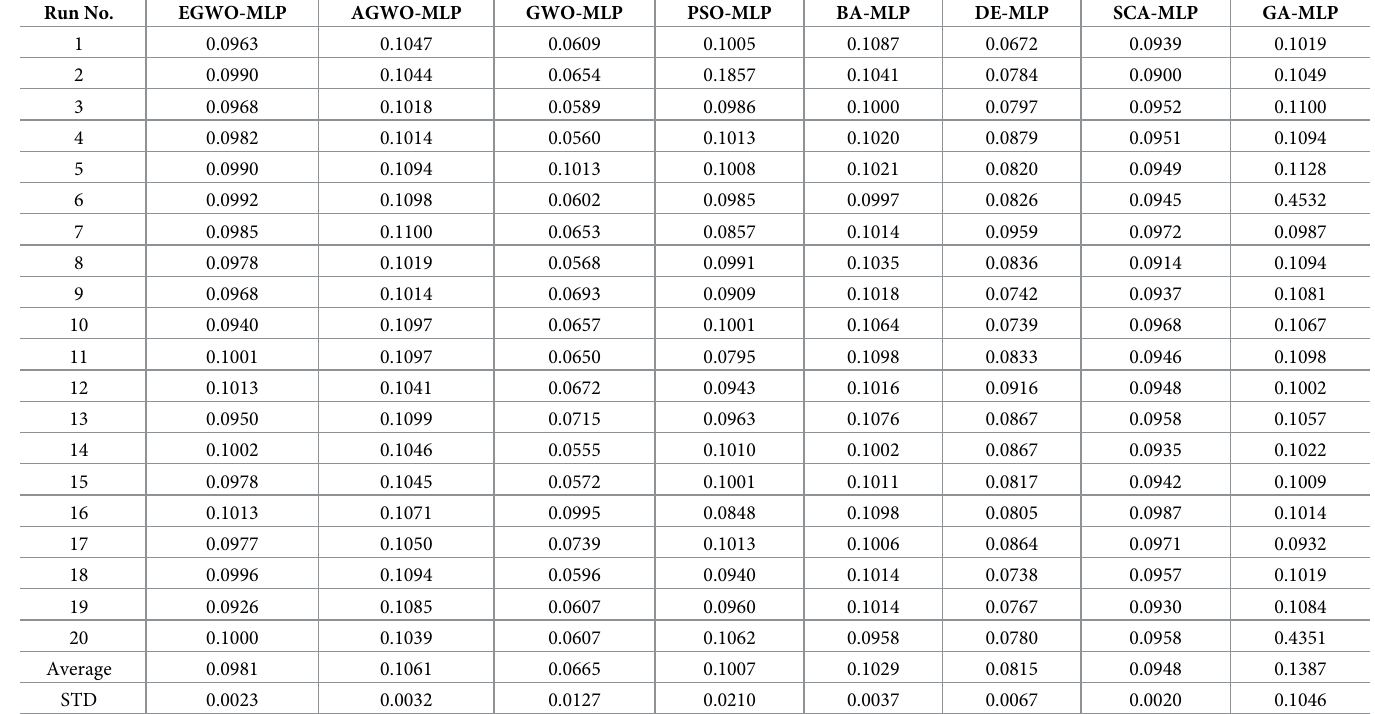
Table 6. The training error for the Portuguese (Por.) subject achievement prediction. Run